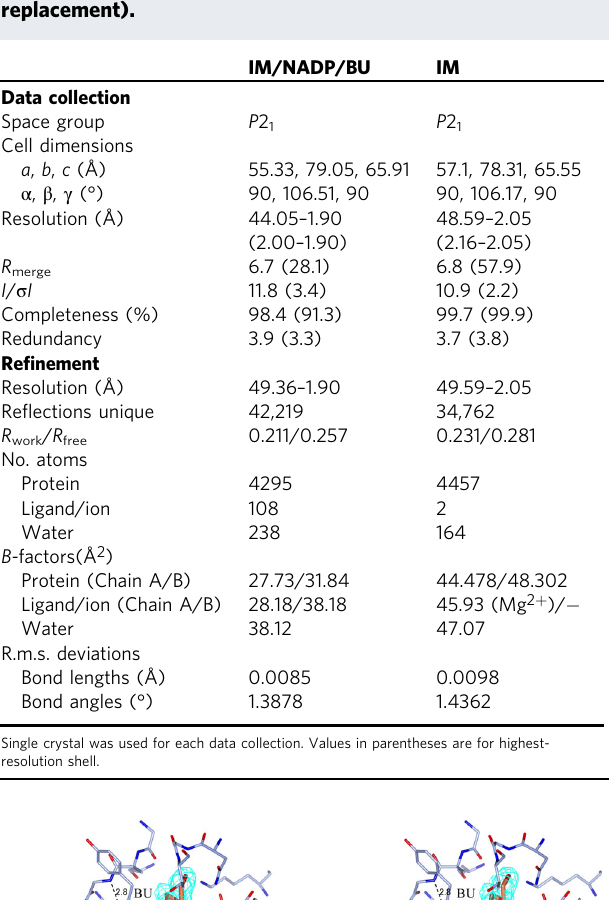
Table 2 Data collection and re fi nement statistics (molecular replacement).